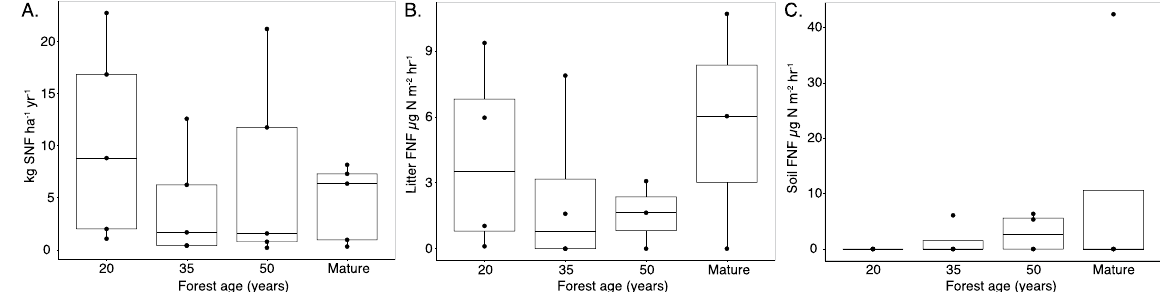
Figure 3. Biological nitrogen fixation along secondary successional forest chronosequence. ( A ) symbiotic nitrogen fixation (SNF), ( B ) leaf litter asymbiotic N fixation (FNF), and ( C ) soil asymbiotic N fixation. Data is shown as boxplot with the median value indicated by the band near the middle of the box, the first and third quartiles are the top and bottom of the box, respectively, the maximum and minimum values excluding outliers are the whiskers. The effect of forest age is not significant for symbiotic nitrogen fixation (p > 0.05; ANOVA) or asymbiotic nitrogen fixation p > 0.05; K-W